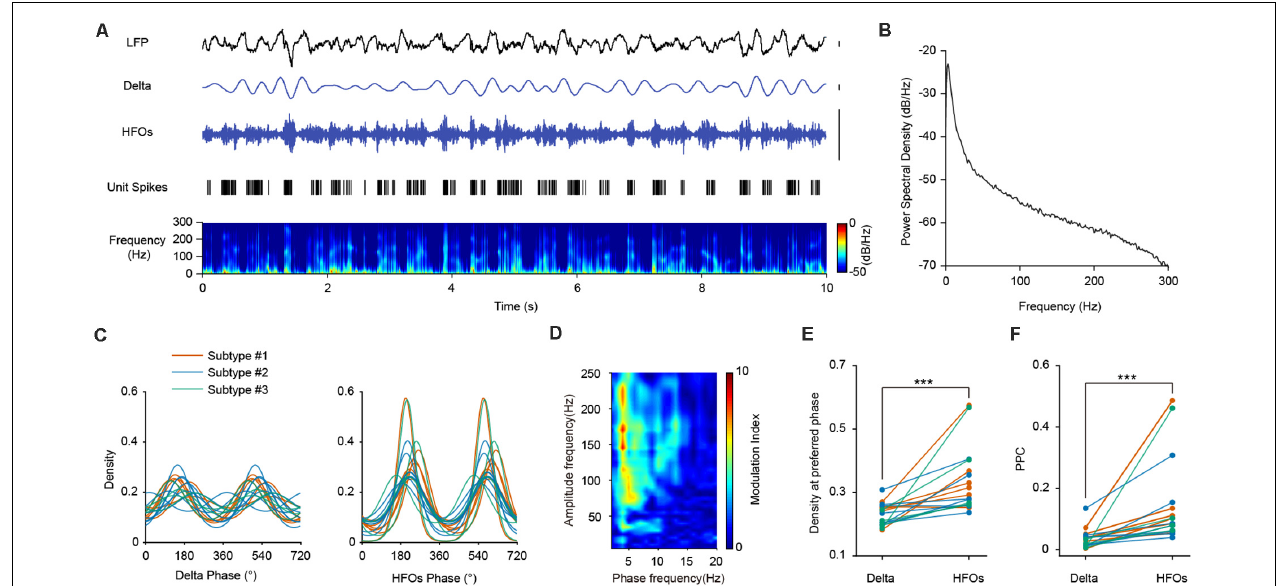
FIGURE 4 | The firing phase-coupling of PFC PV interneurons to LFP HFOs during SWS state. (A) Example traces showing PV interneuron spikes and different LFP oscillation components during SWS. The illustrated PV interneuron exhibited correlated firing with HFO events. Traces from top to bottom, PFC LFP signal, delta oscillation, HFOs filtered from LFP, PV interneuron spiking activity (each stick represents one action potential fired by the neuron), and power spectrogram of LFP (10 s of data is shown, scale, 0.1 mV). Note the highly correlated activities of neuronal spiking and HFOs. (B) Power spectral density during SWS state of one example recording. (C) Firing phase distribution of 3 subtypes of PV interneuron spikes with delta and HFO during SWS. Each colored line represents one single neuron ( n = 18 neurons). The firing activities of all the recorded interneurons are significantly phase-locked to both delta and HFOs. (D) Phase-amplitude coupling analysis of mPFC LFP during SWS. (E) Peak phase coupling density with different oscillations at preferred phase of PV interneuron spikes during SWS state (Wilcoxon Signed Ranks Test, ***, p = 3.27e-4, n = 18 neurons). (F) Comparison of PPC of PV interneuron spikes with delta and HFOs during SWS states (Wilcoxon Signed Ranks Test, ***, p = 1.96e-4, n = 18 neurons).